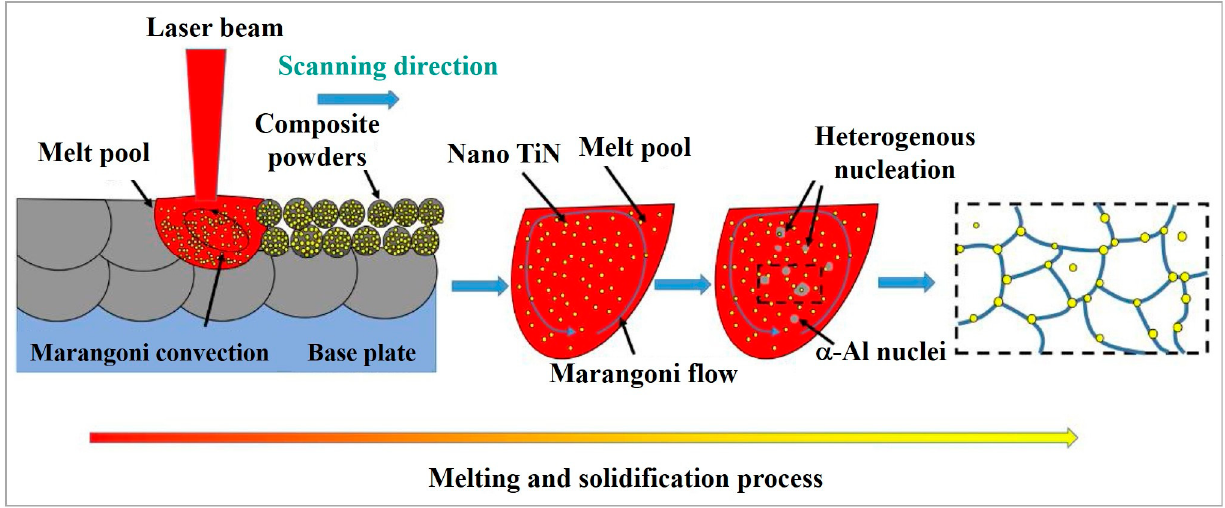
Figure 20. Graphical illustration demonstrating the morphology evolution for the TiN/AlSi10Mg AMC during LPBF (reproduced with permission from [101]).